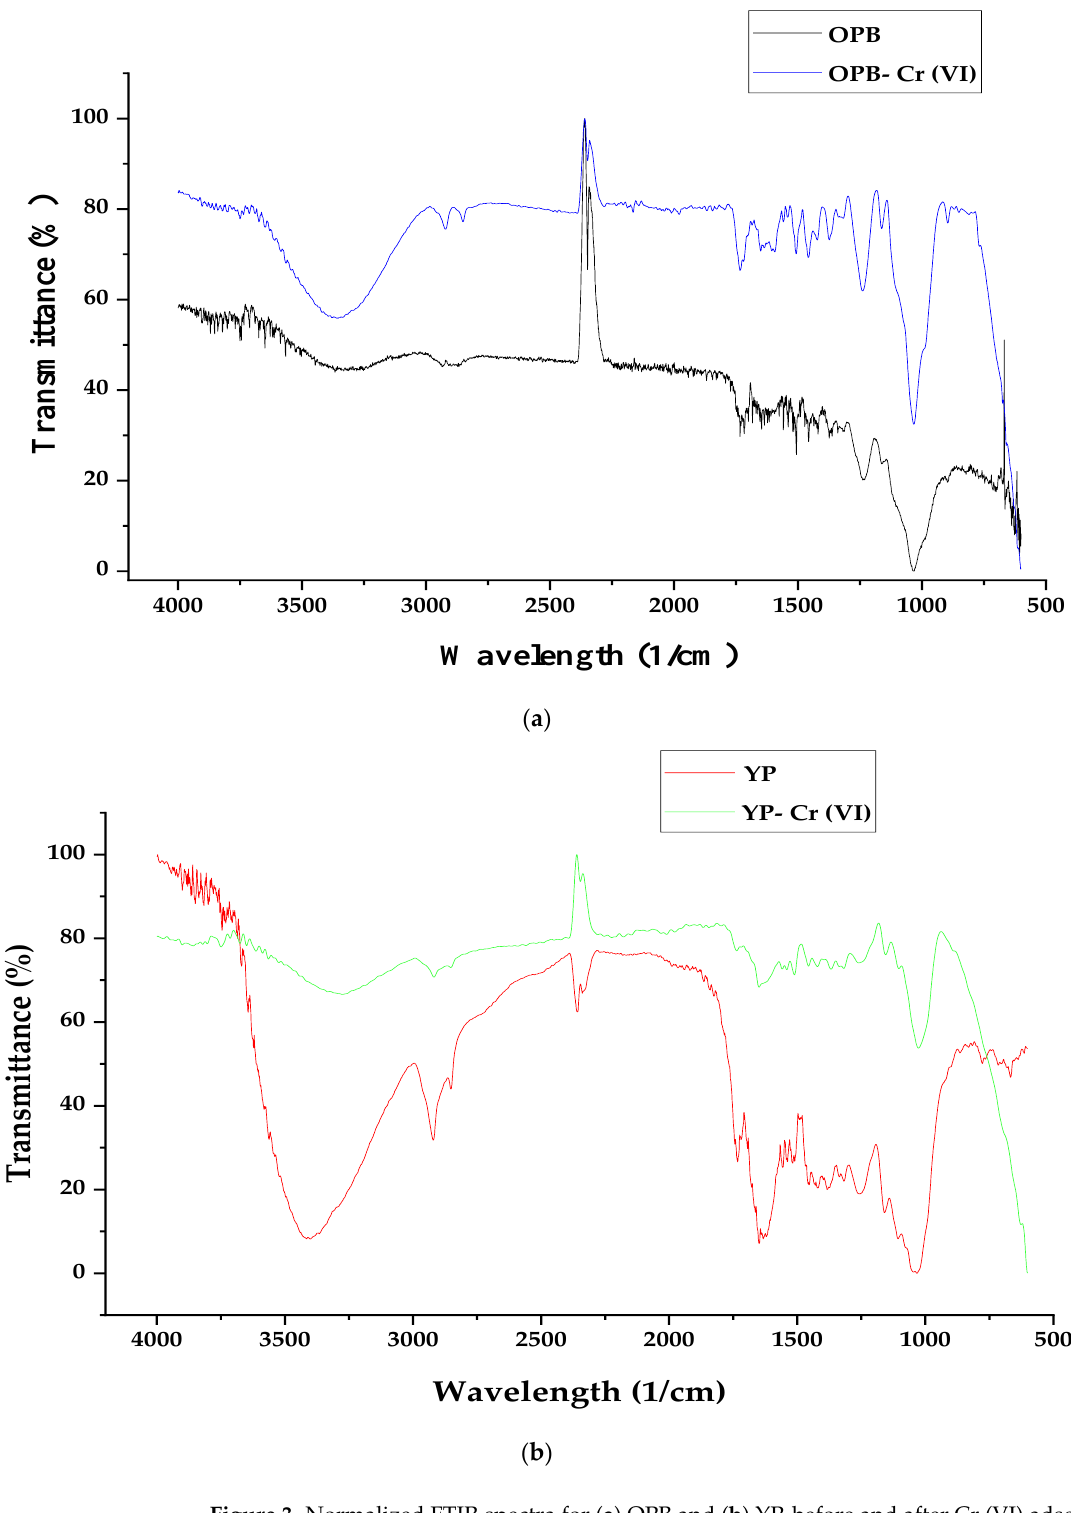
Figure 3. Normalized FTIR spectra for ( a ) OPB and ( b ) YP, before and after Cr (VI) adsorption. The spectrum in Figure 3 initially shows a broad band at 3400 cm − 1 that is attributed to the stretching vibrations of the OH bond, while the peaks at 2950 cm − 1 and 1350 cm −